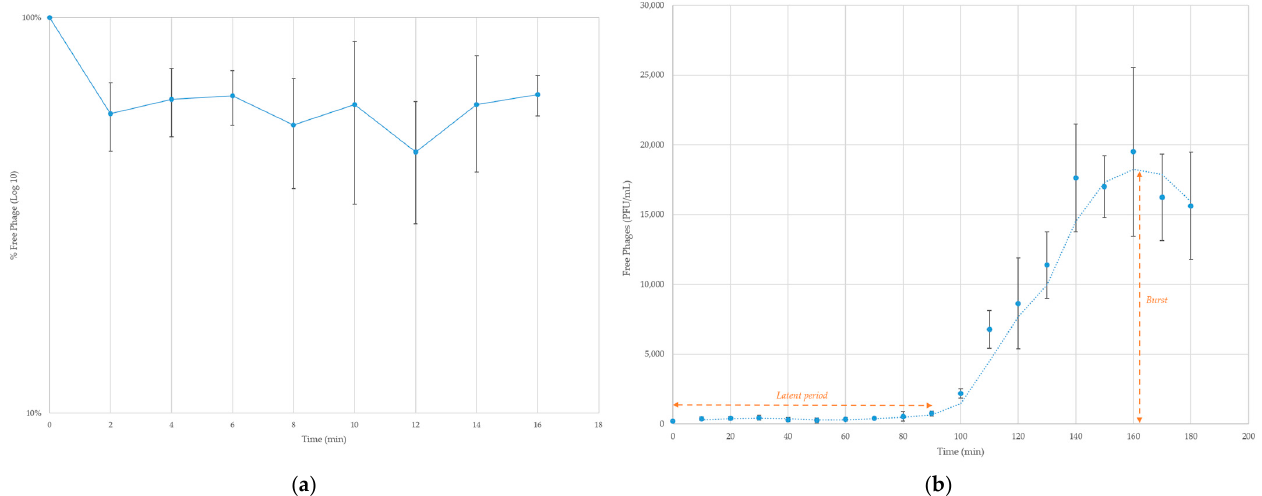
Figure 3. Phage kinetics of 4HA13. ( a ) Adsorption of 4HA13 to E. coli O111:NM over 16 min; ( b ) one-step growth curve of 4HA13 to E. coli O111:NM. The latent period and burst are marked by orange dash lines.